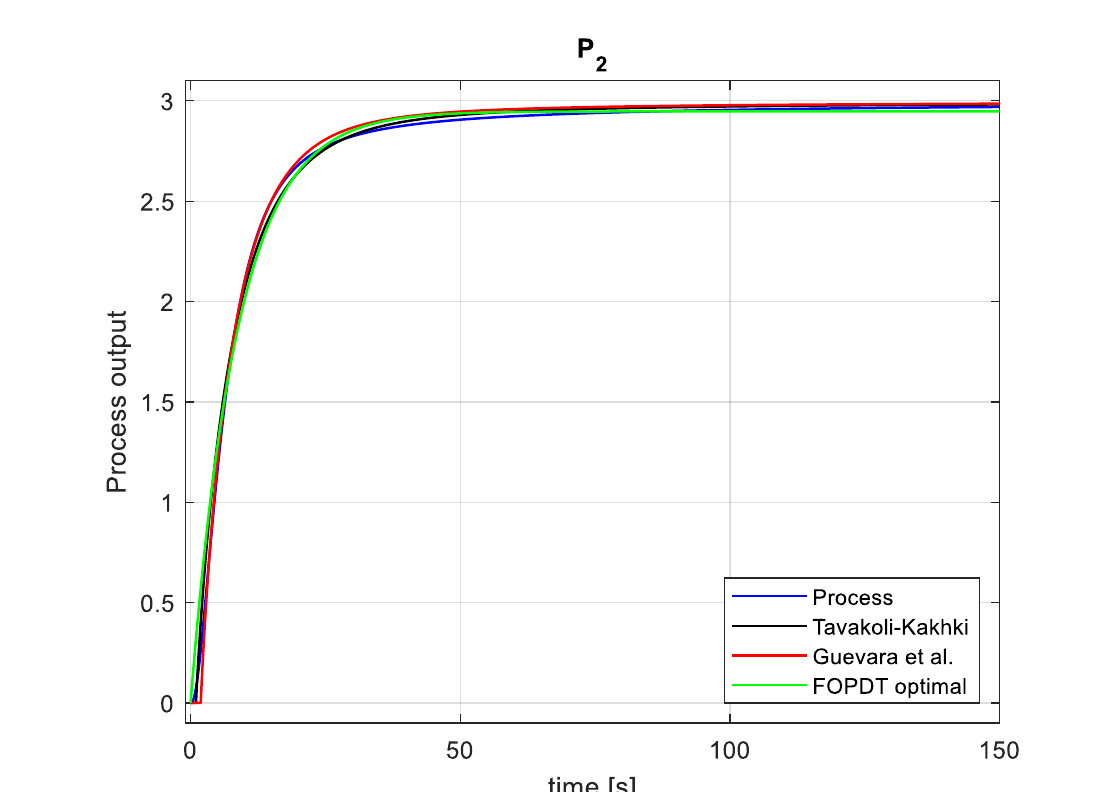
Figure 17. FFOPDT model step response using the proposed identification method for process P 2 and process reaction curve: ( a ) Asymmetrical set of points (20-60-95%); ( b ) Asymmetrical set of points (20-75-95%).